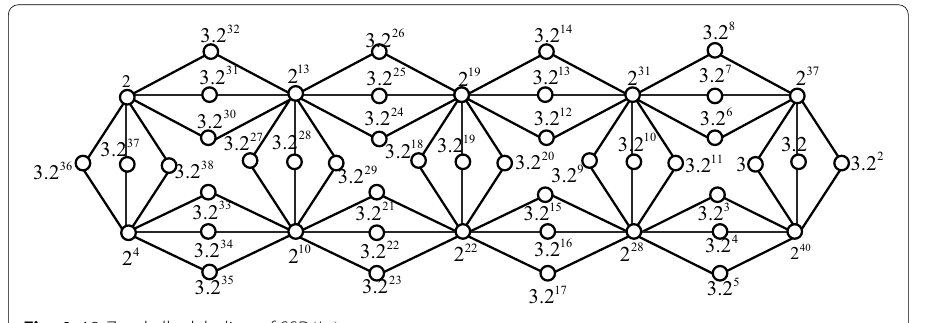
Fig. 4 12-Zumkeller labeling of SSD ( L 5